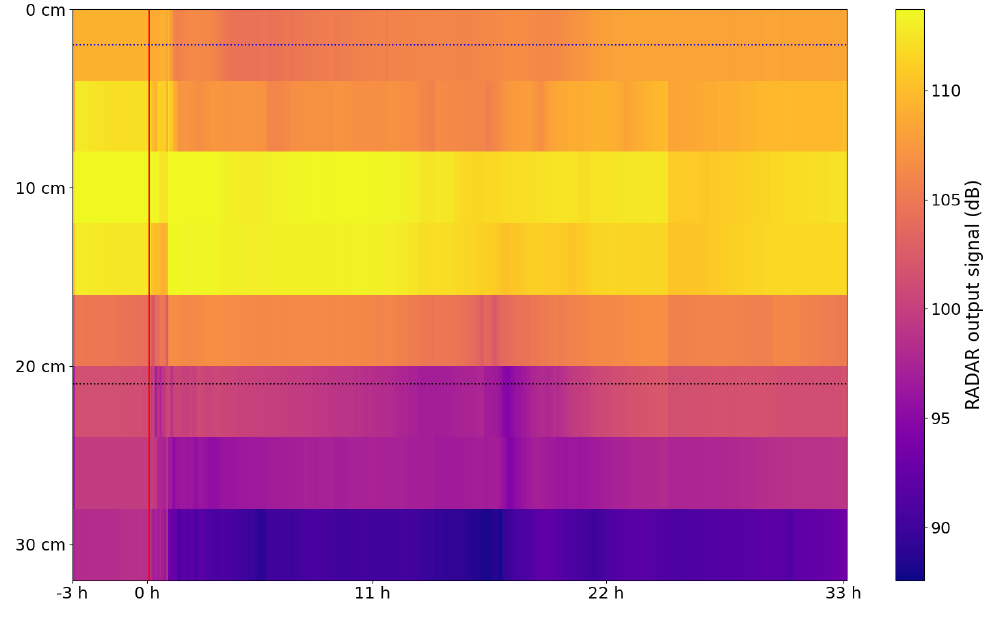
Figure 4. Spatiotemporal pattern of the RADAR’s readings. Warmer colors represent a higher intensity of the signal that relates to drier soil. The vertical red line represents the moment when the water was added. The blue and black dotted lines represent the depths where the two ground-truth sensors were